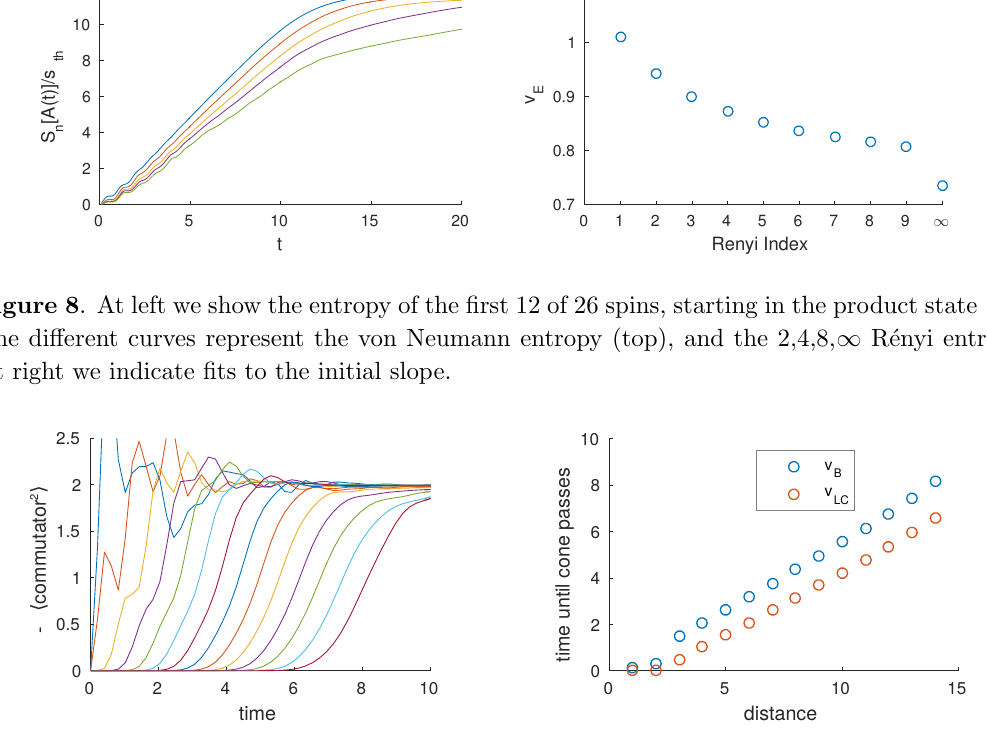
Figure 9 . At left we show the commutator (cid:0)h [ (cid:27) (1) y ( t ) ; (cid:27) ( k ) y ] 2 i for k = 1 : : : 14, in the in(cid:12)nite temperature state. At right we show the times at which the commutators for the di(cid:11)erent values of k pass 1 ( v B cone) and 0 : 1 ( v LC cone). Linear (cid:12)ts between 3 ; 13 give v LC = 1 : 85 and v B = 1 :